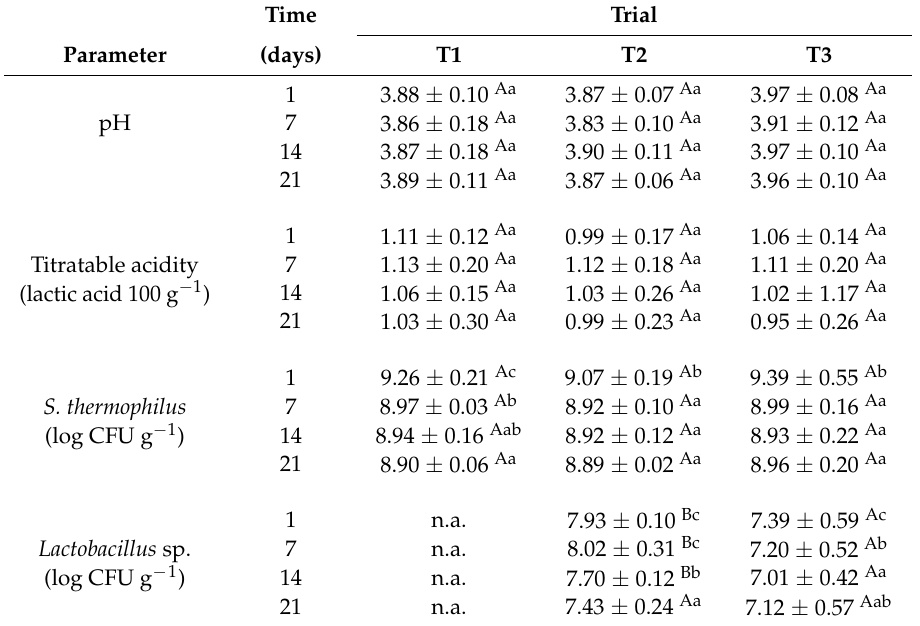
Table 3. Changes in mean values of pH, titratable acidity and in populations of S. thermophilus and Lactobacillus sp . of the fermented dairy dessert trials containing jabuticaba peel ingredients after 1, 7, 14 and 21 days of storage at 4 ± 1 ◦